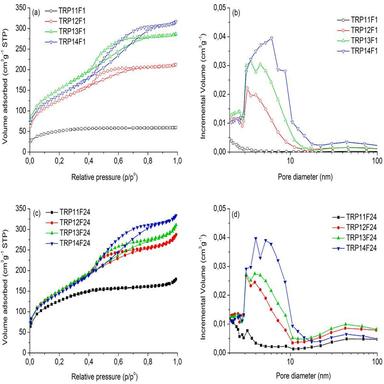
N2 adsorption-desorption isotherms (a, c) and PSDs (b, d) of SiOC-DC materials after HF etching during 1 or 24 h.